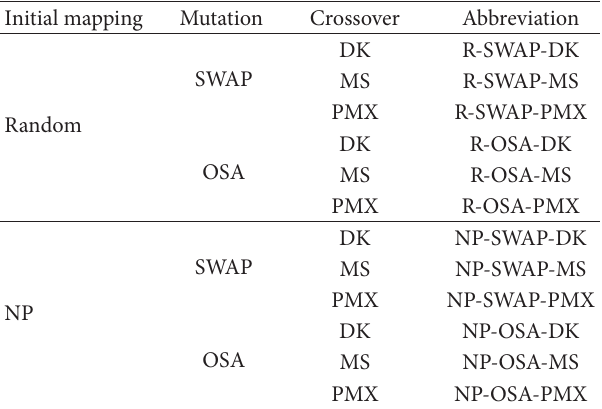
Table 1: Overview of the algorithms used in application mapping